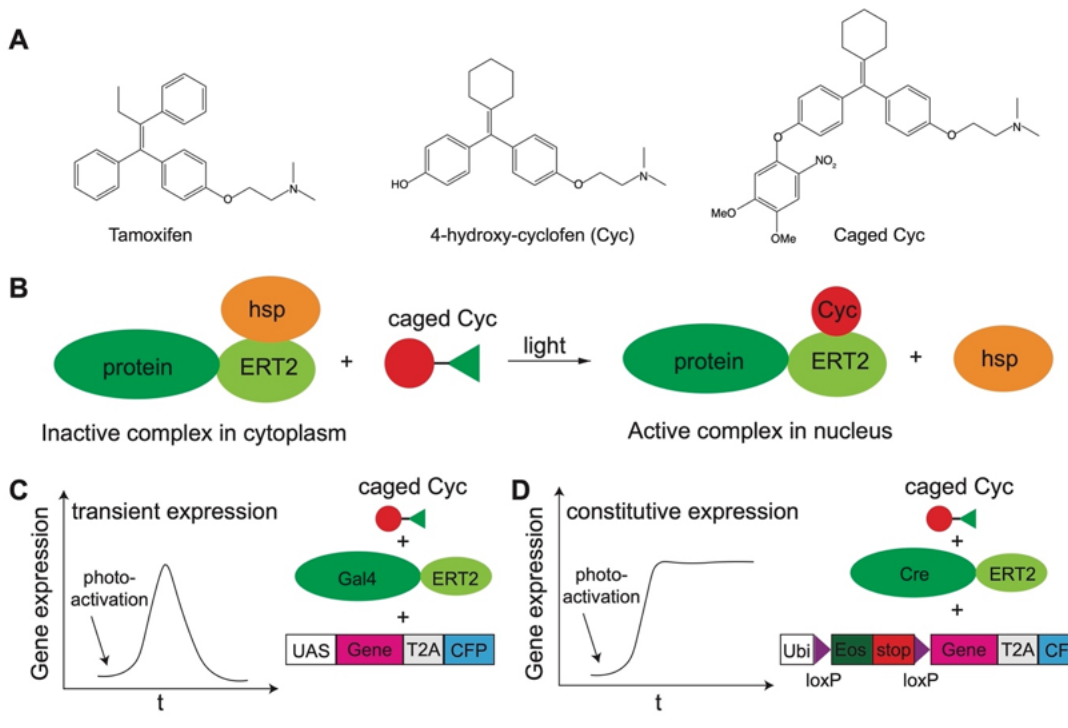
Figure 4. Optical control of protein activity and gene expression with caged Cyc. ( A ) Chemical structures of tamoxifen, Cyc and caged Cyc. ( B ) Optical control of protein activity with caged Cyc. Optical control of transient ( C ) or constitutive ( D ) gene expression with caged Cyc. The transient and constitutive expression of the gene of interest is driven by a UAS or a ubiquitin (Ubi) promoter, respectively. Cyan fluorescent protein (CFP) is used as an expression marker. Schemes are adapted from Refs.